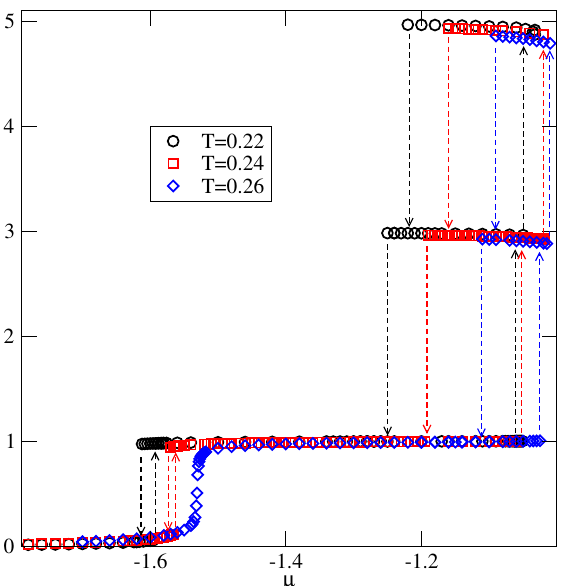
Figure 23. The excess adsorption isotherms for the system with V A = − 1.0 and V B = −